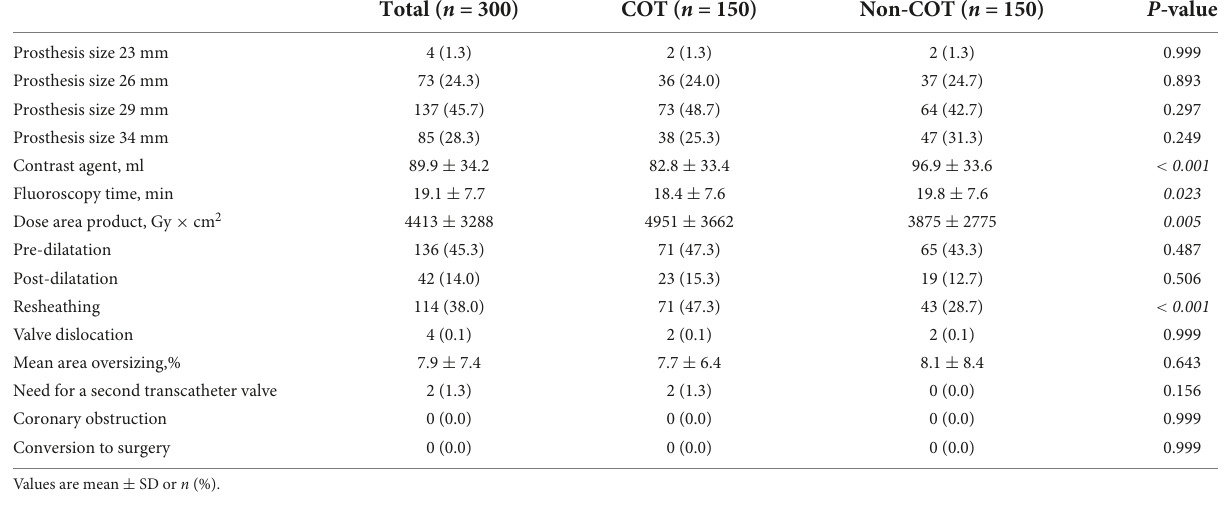
TABLE 3 Procedural characteristics in matched cohorts.